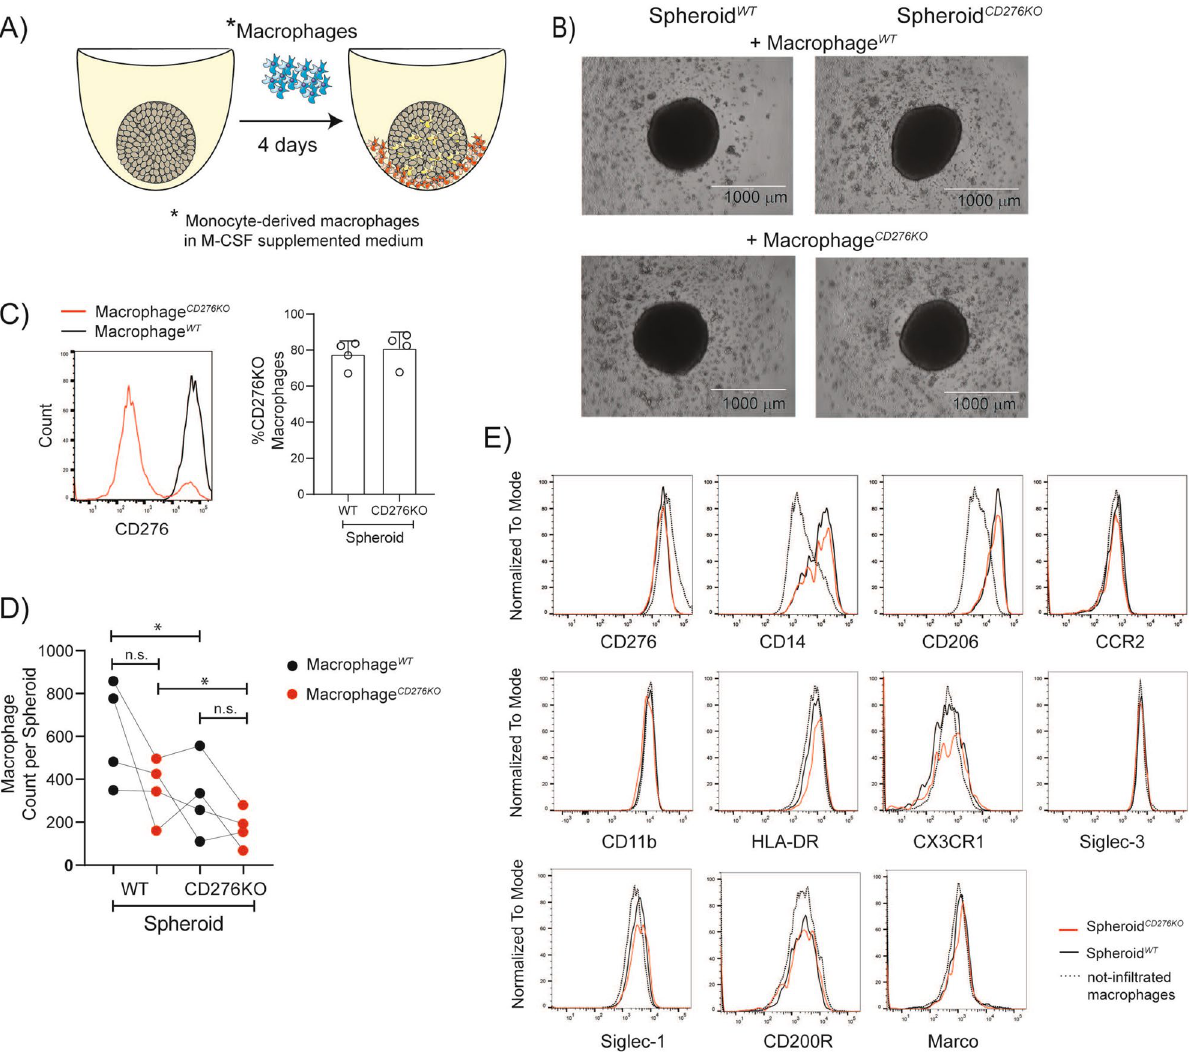
Figure 3. In the absence of CD276 on tumor cells, lower number of macrophages infiltrates into spheroids. Macrophages (MDMs in M-CSF supplemented medium) were genetically edited with Crispr-Cas9 protocol by CD276 specific gRNA (Macrophage CD276KO ). Control cells were treated with scrambled gRNA (Macrophage WT ). Afterwards, cells were rested for 7 days in culture and then cocultured with spheroids for another 4 days. CD11b + MDMs inside the spheroids were analyzed by flow cytometry. ( A) A schematic representation of experimental set-up for tumor spheroid culture with macrophages. 5 days after seeding HCT116 WT or HCT116 CD276KO cells, Macrophages WT or Macrophages CD276KO were added to the spheroids. 4 days after coculture, a fraction of macrophages infiltrated into the spheroid (yellow), while some macrophages (orange) remain attached in the well, outside of the spheroid. ( B) Microscopy images show spheroid-macrophage cocultures for indicated conditions. ( C) Histogram displays CD276 expression on Macrophage WT (black line) and Macrophage CD276KO (red line) in the spheroids. The graph summarizes the percentage of Macrophage CD276KO among infiltrated macrophages Spheroid WT and Spheroid CD276KO coculture from four different donors. ( D) The count of infiltrated MDMs per spheroid is depicted in the graph. Briefly, 10 spheroids were pooled into a single sample for each group and before dissociation a defined number of negative compensation flow cytometry beads were added. Ratio of recorded bead count to the initial bead amount was used to back calculate MDMs. Macrophage WT (black dots); Macrophage CD276KO (red dots). Each dot represents one MDM donor. Statistical analysis was done with paired t -test; *p < 0.05. n.s. = not-significant E) Histograms display the surface expression of indicated markers on Macrophage WT inside of Spheroid WT (black line) versus Spheroid CD276KO (red line) in comparison to not-infiltrated macrophages (dashed line) that were outside of the Spheroid WT . The data represent one donor from 4 donors MDMs (Macrophage WT